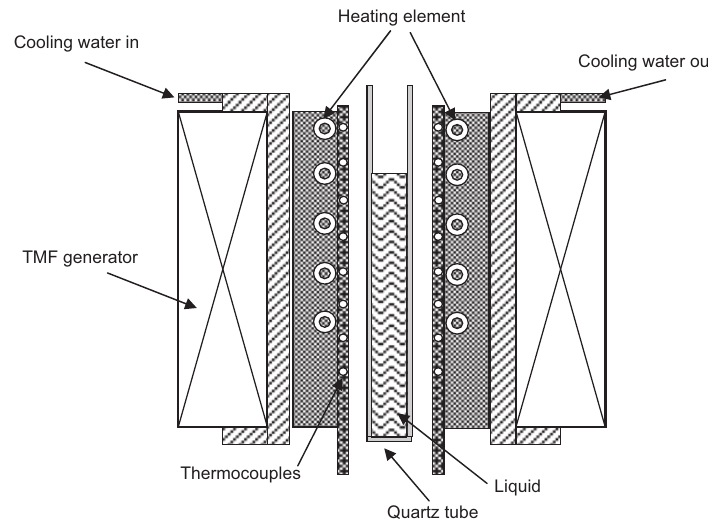
Figure 1 Schematic of the experimental apparatus for metal solidifi cation under a